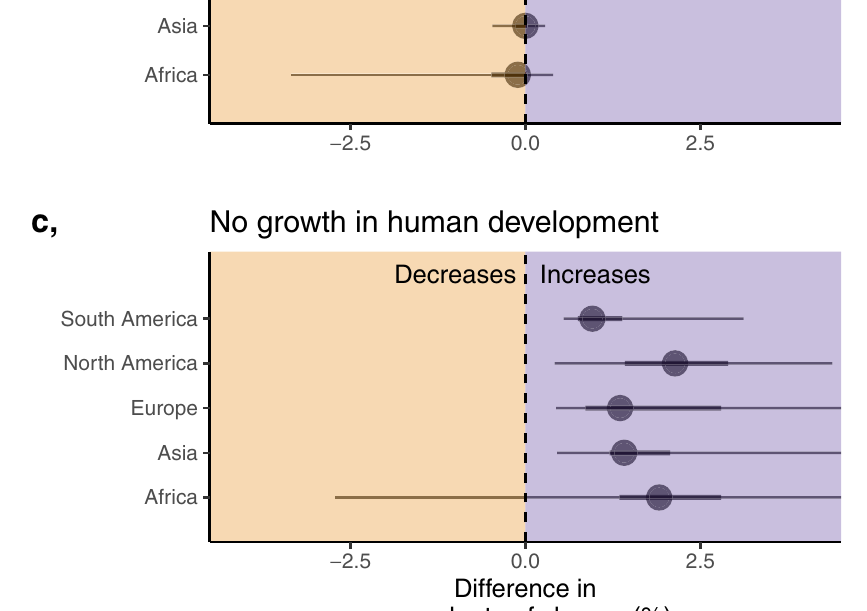
growth not occurred, and populations on the leftof the line wouldbe predicted to decrease. Points represent the median difference in the annual rate of change (predicted trend using counterfactual data minus the predicted trend using the observed data), with 50 and 95% quantiles. Source data are provided as a Source Data fi